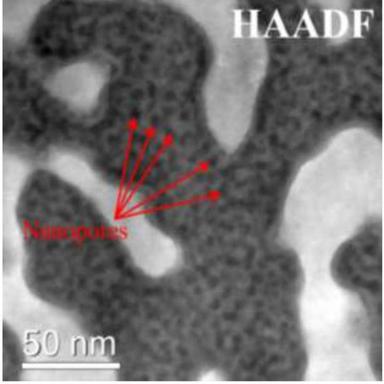
Nanoporosity in the oxide phase. (a) HAADF image showing the two-phase structure of the inner oxide layer (TEM sample 2); (b) quantitative and (c) qualitative EELS chemical composition maps showing the distribution of O, Cr, Fe, and Ni.